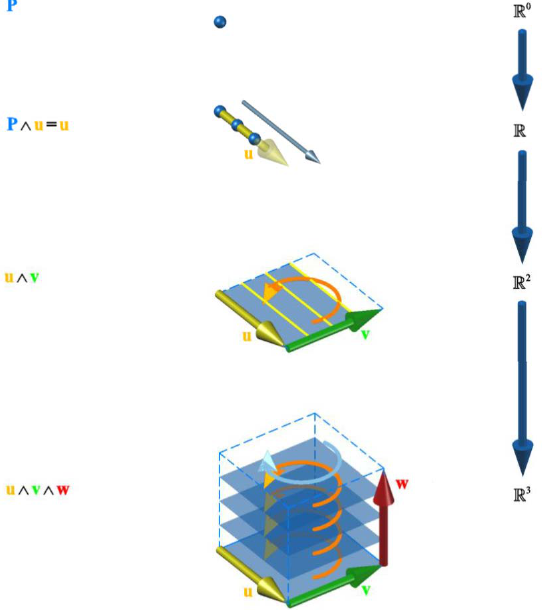
Figure 14: The inner orientation of a p -space element is induced by the ( p − 1) -space elements on its